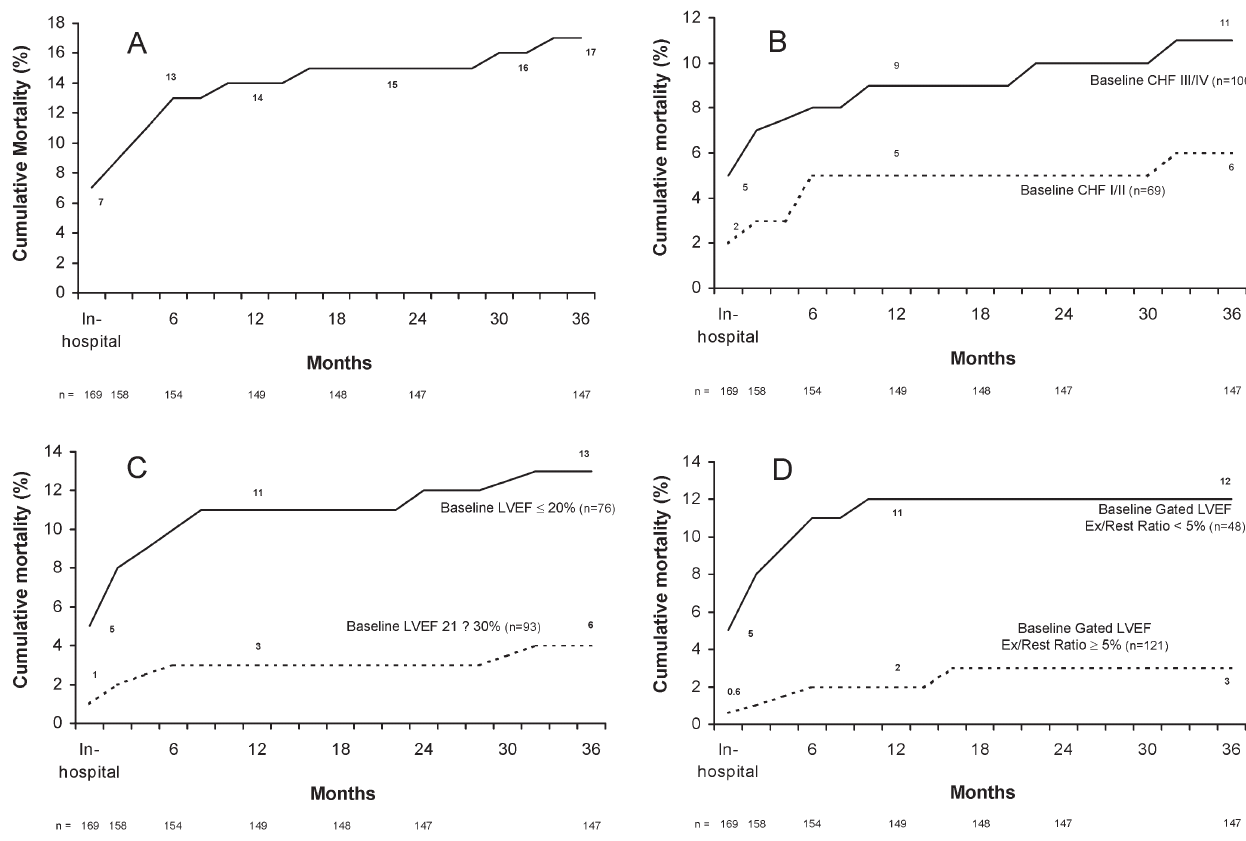
Figure 2 - Cumulative mortality: A, global; B, according to baseline congestive heart failure New York Heart Association classification (CHF NYHF); C, according to baseline left ventricular ejection fraction (LVEF); D, according to baseline gated left ventricular ejection fraction (LVEF) exercise (ex)/rest ratio.